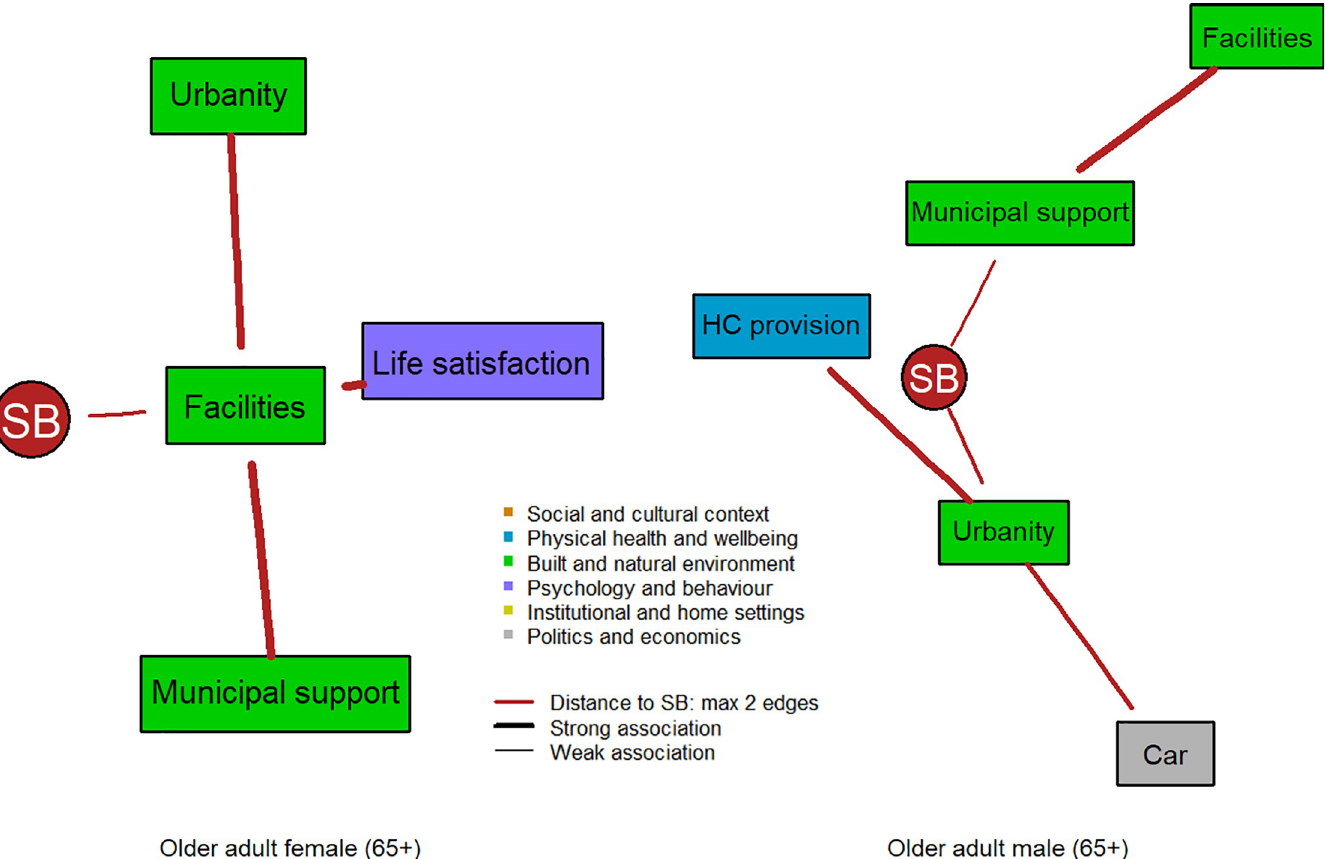
Fig 5. Factors linked to SB within two edges distance in the subgraphs for older adult females (5a: left; N = 2,612) and older adult males (5b: right; 3,071).